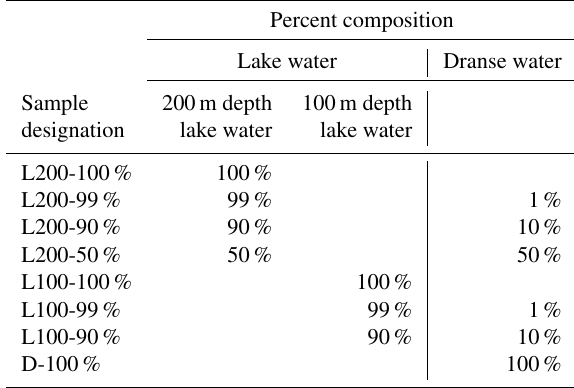
Table 1. Design of the incubation